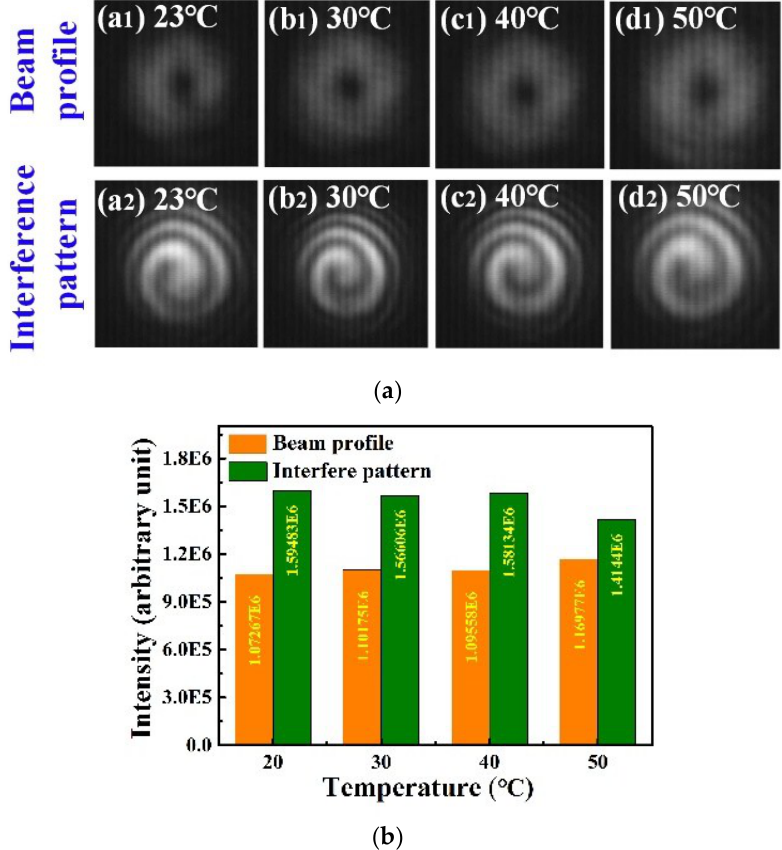
Figure 7. ( a ) Beam profiles and interference patterns of OAM modes generated by the LPFG as the temperature increased from 23 °C to 50 °C; ( b ) The intensity (a. u.), calculated by MATLAB, changed with the temperature increasing from 23 °C to 50 °C.